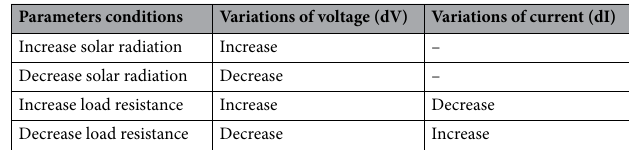
Table 1. The variation of PV panels voltage and current as solar radiation and load resistance